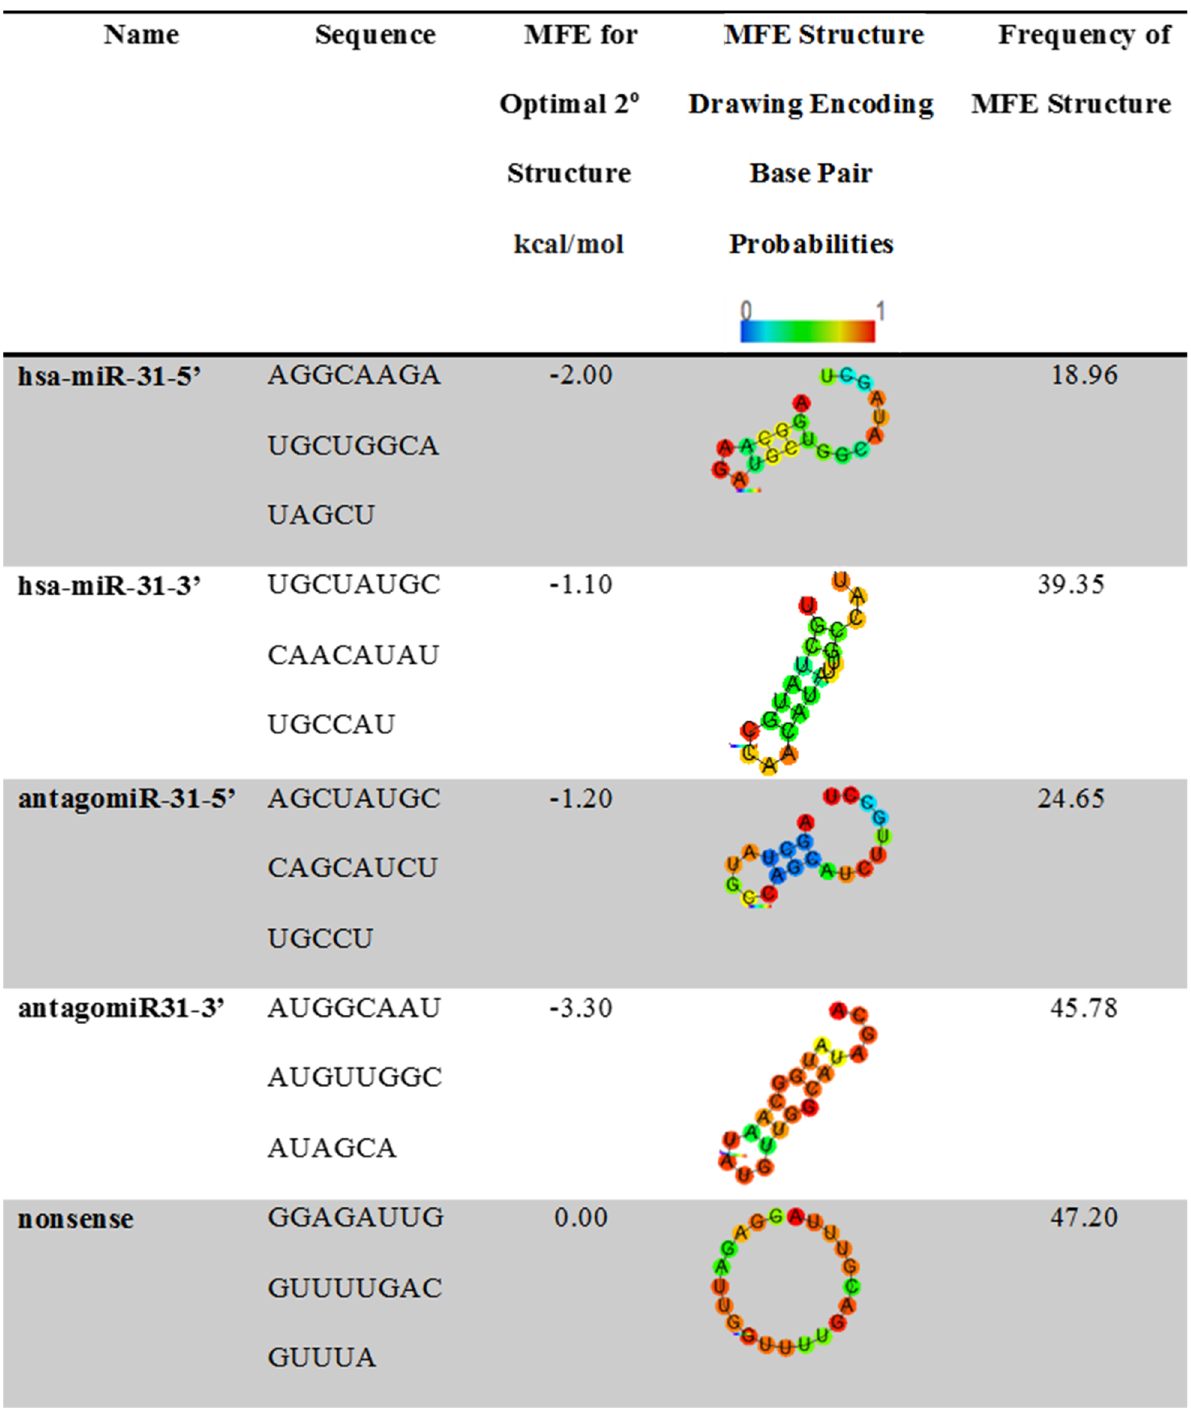
Fig 8. Predicted structures of the single stranded RNA sequences. Structures are based on the minimal free energy (MFE) method (an established method to predict RNA structure). Complimentary regions are evaluated to predict the most energetically stable molecule. The stability of the structure is given in kcal/mol, the more negative the value equates to a more stable structure (‘hsa’ denotes species; Homo sapiens).